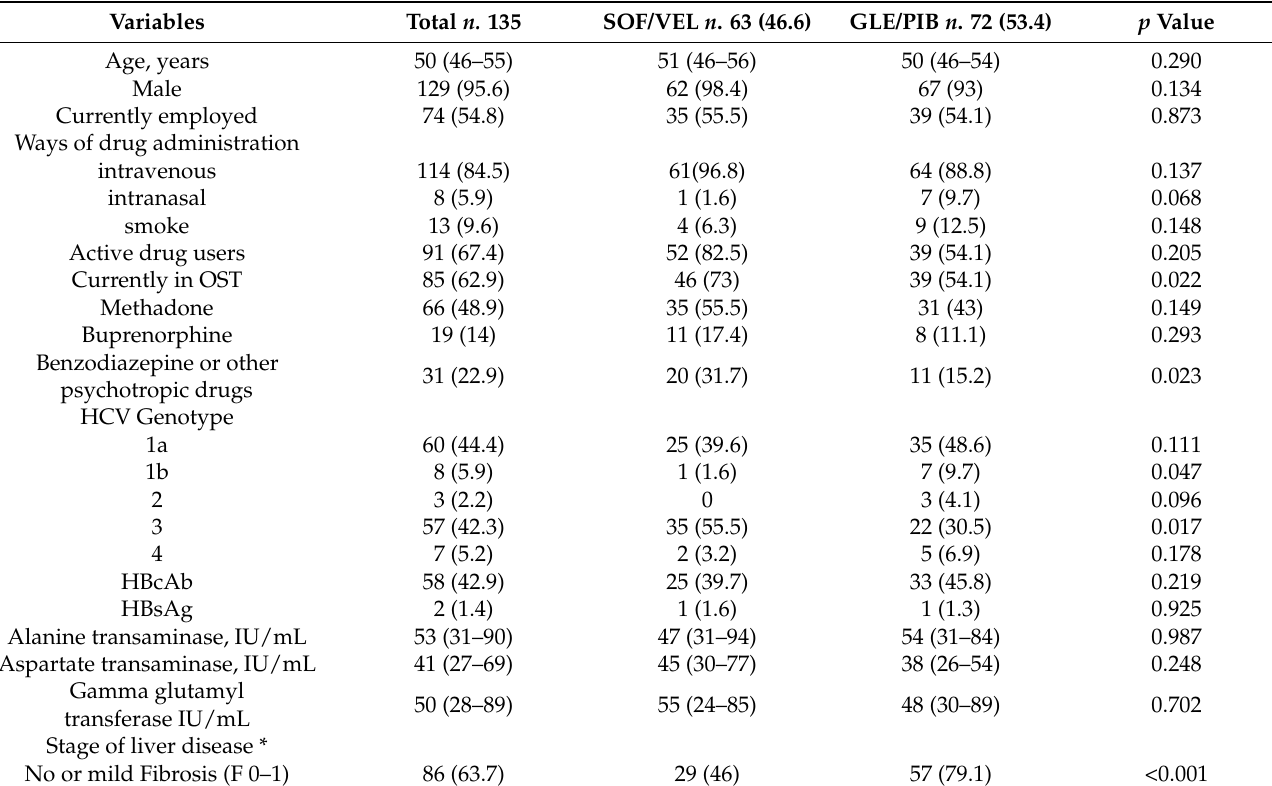
Table 1. Clinical features of PWUDs treated matched by DAAs